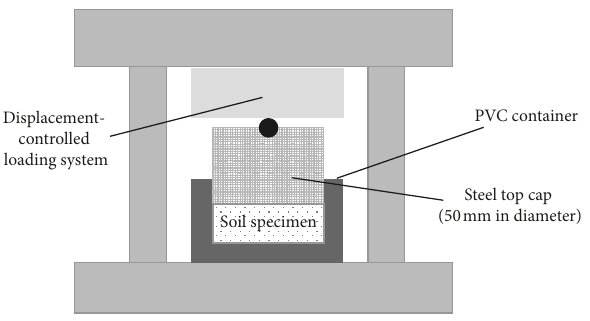
Figure 2: Controlling dry density using the displacement-con- trolled loading